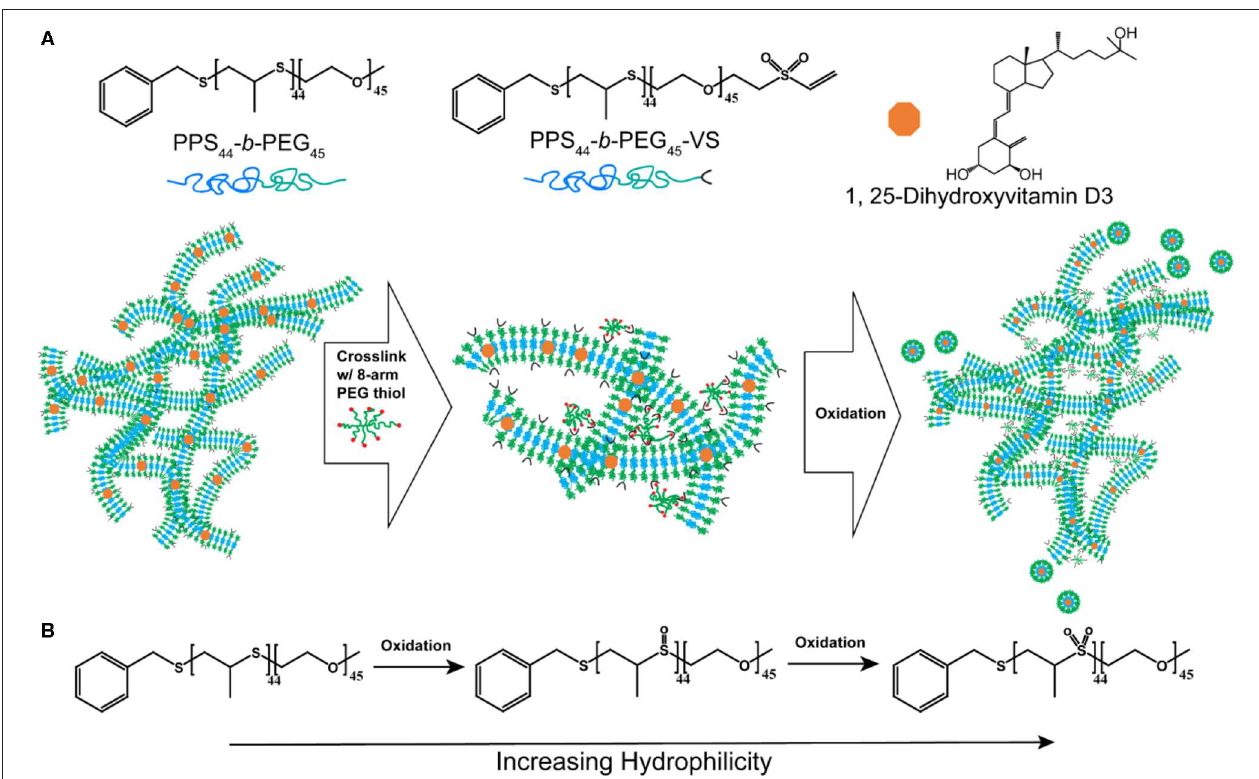
FIGURE 1 | The strategy for sustainably delivering aVD-loaded nanostructures from FM-depots. (A) Schematic of the PEG- b -PPS copolymers and 1,25-Dihyroxyvitamin D3 (aVD) structures and aVD-loaded filomicelle hydrogel formation. aVD was loaded in filomicelles assembled from PEG- b -PPS polymers with 20% vinyl sulfone (VS) functionalization. aVD-loaded FM-depots were formed following crosslinking of VS moieties with 8-arm PEG thiol. aVD-loaded micelles (MC) release from aVD-FM-depots in response to physiological oxidation at the site of injection. (B) This thermodynamically driven cylinder-to-sphere transition occurs due to modulation of the hydrophilic/hydrophobic ratio within the filomicelles as the PPS hydrophobic block oxidizes into polypropylene sulfoxide and sulfone